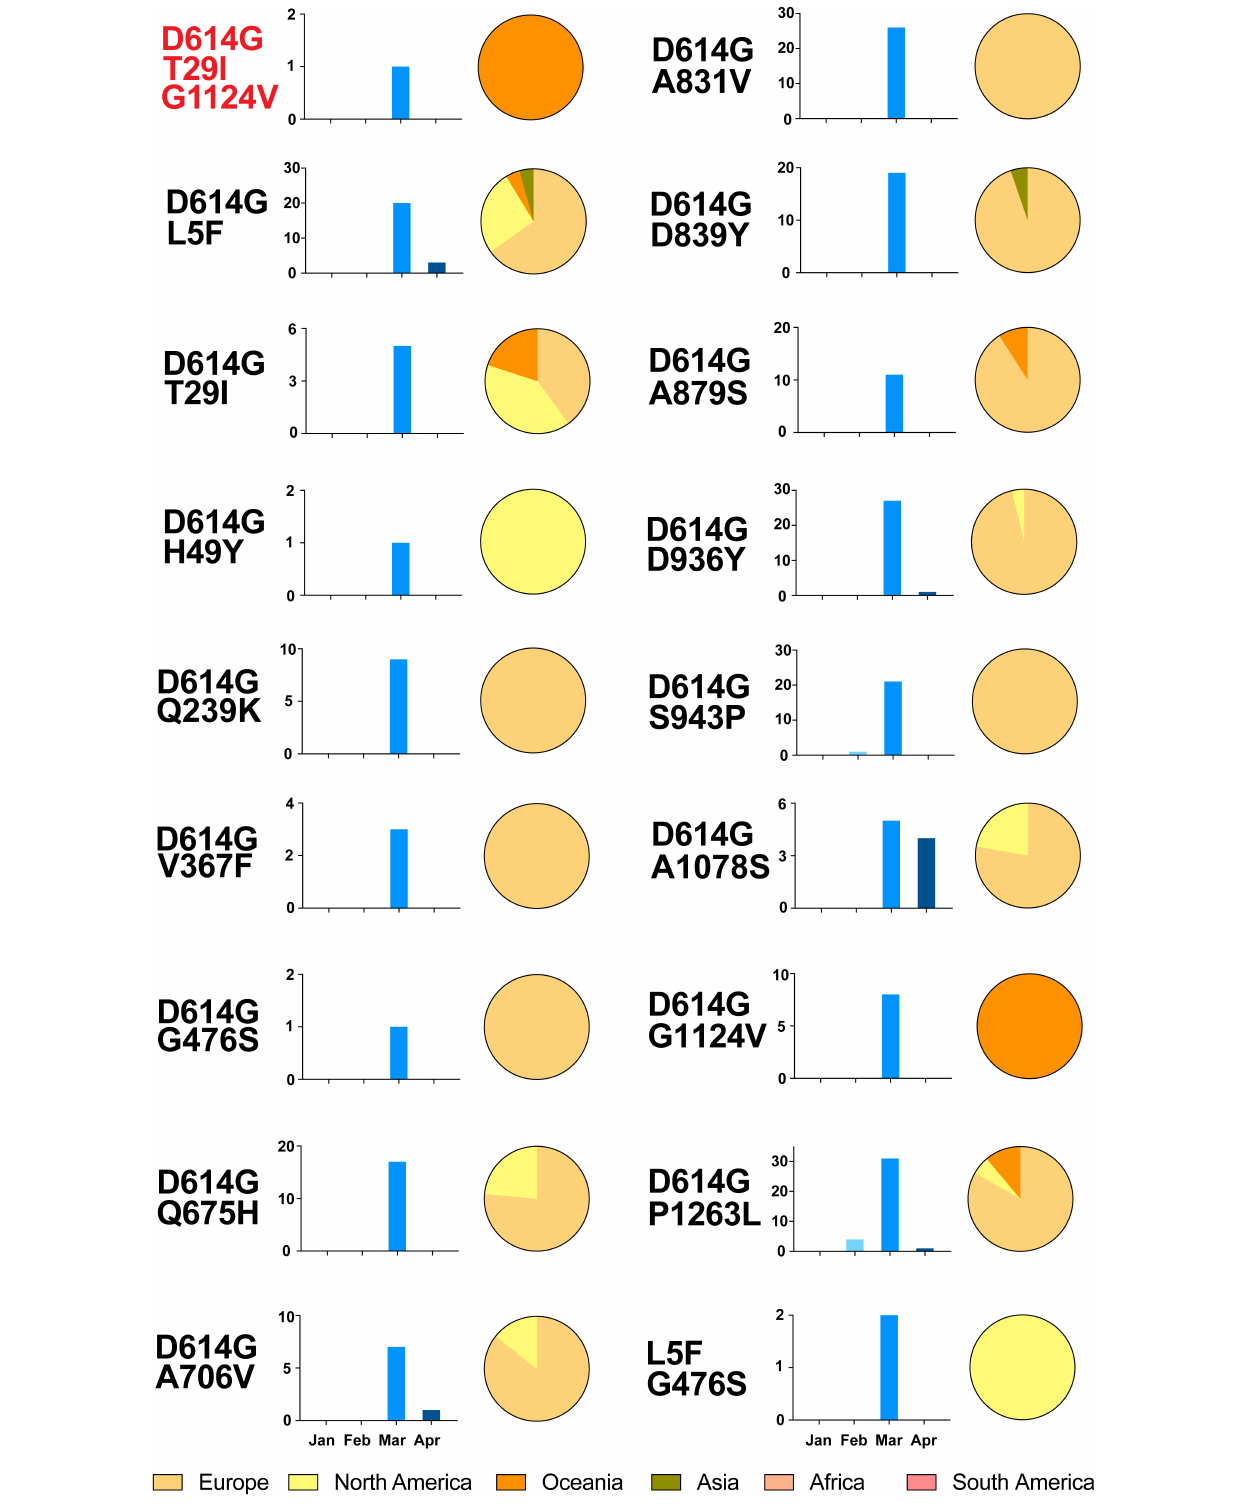
FIGURE 4 | Temporal and geographical distributions of the sequences of variants with multiple relatively high-frequency amino acid variations on SARS-CoV-2 spike protein. A total of 18 kinds and 228 sequences of variants had multiple relatively high frequency variations. All of them had two variations, except one with